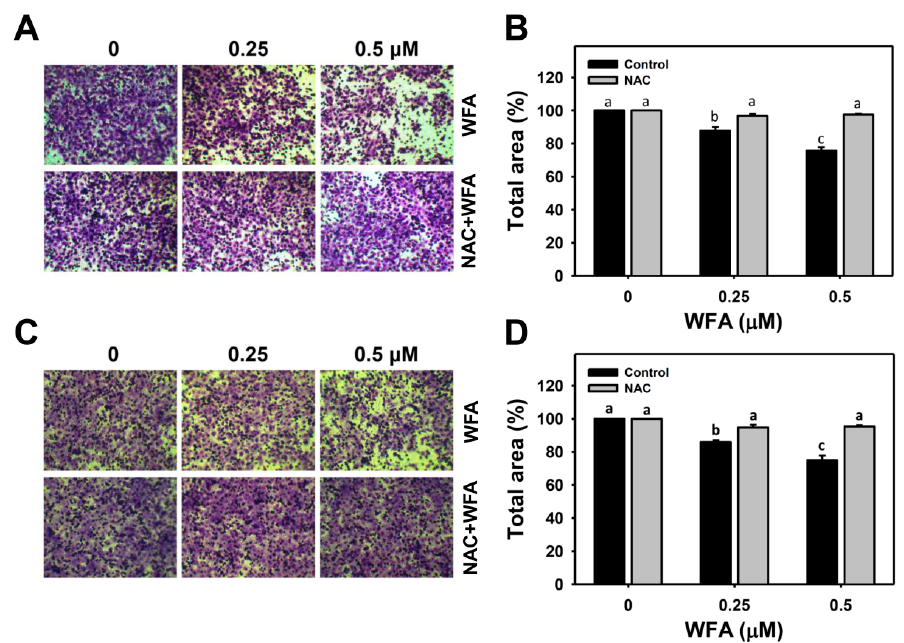
Figure 4. Three-dimensional anti-migration and -invasion effects of low concentrations of WFA in oral cancer cells. ( A , C ) 3D migration and invasion images of Ca9-22 cells after NAC and/or WFA treatments. Cells were pretreated with or without NAC (2 mM, 1 h) and post-treated with different concentrations of WFA for 21 h. ( B , D ) Statistics of 3D migration and invasion changes in Figure 4A,B. For multiple comparison, treatments without the same labels (a to c) indicate the significant difference. p < 0.001~0.0001 ( B ) and p < 0.01~0.001 ( D ). Data, mean ± SD ( n = 3).